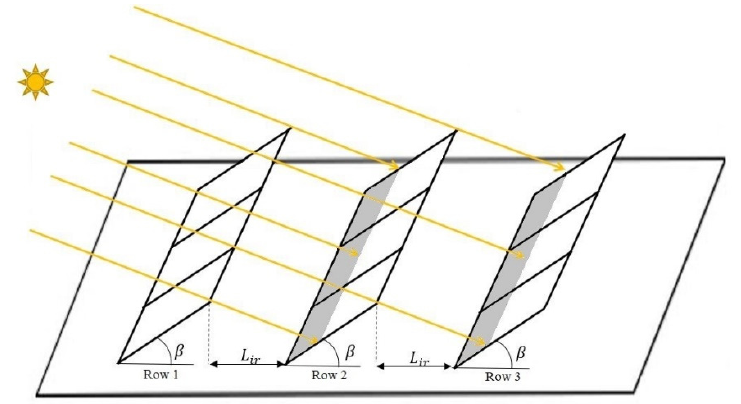
Figure 3. Schematic of PV system with shading.